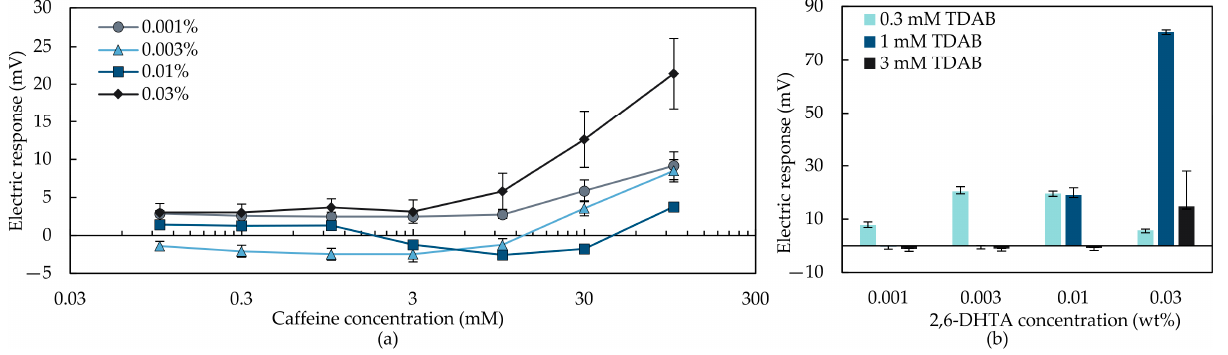
Figure 6. Response to caffeine in sample solutions measured using taste sensors with the membrane modified with 2,6-DHTA: ( a ) Concentration of caffeine determined using the taste sensors with 0.3 mM TDAB membrane modified with different concentrations of 2,6-DHTA as a function of the response value; ( b ) electric response to 100 mM caffeine when using lipid/polymer membrane modified with different concentrations of 2,6-DHTA. The error bar indicates the SD of data, n = 4 (electrode) × 4 (rotation) = 16 values.